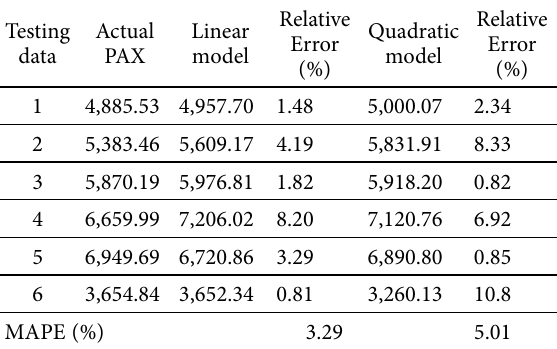
Table 1. A comparison of the GAPAXDE linear and quadratic modelling results with the observed data for the testing period Testing data